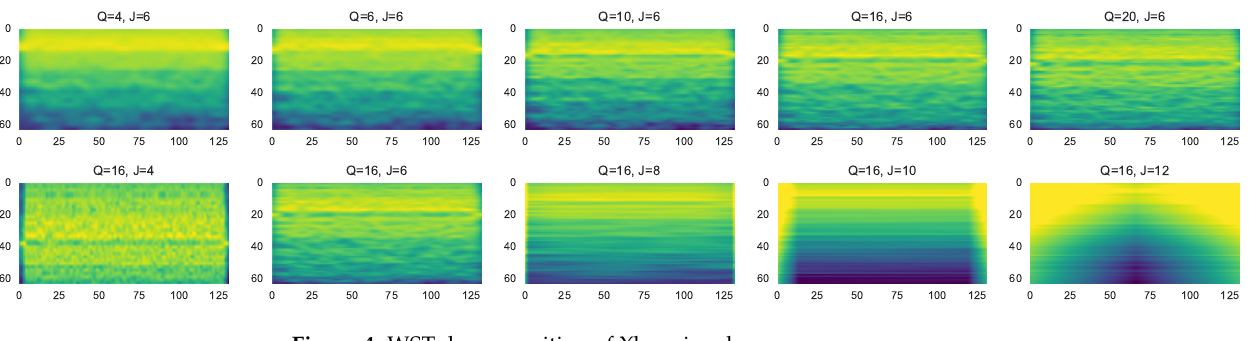
Figure 4. WST decomposition of Xbee signal.